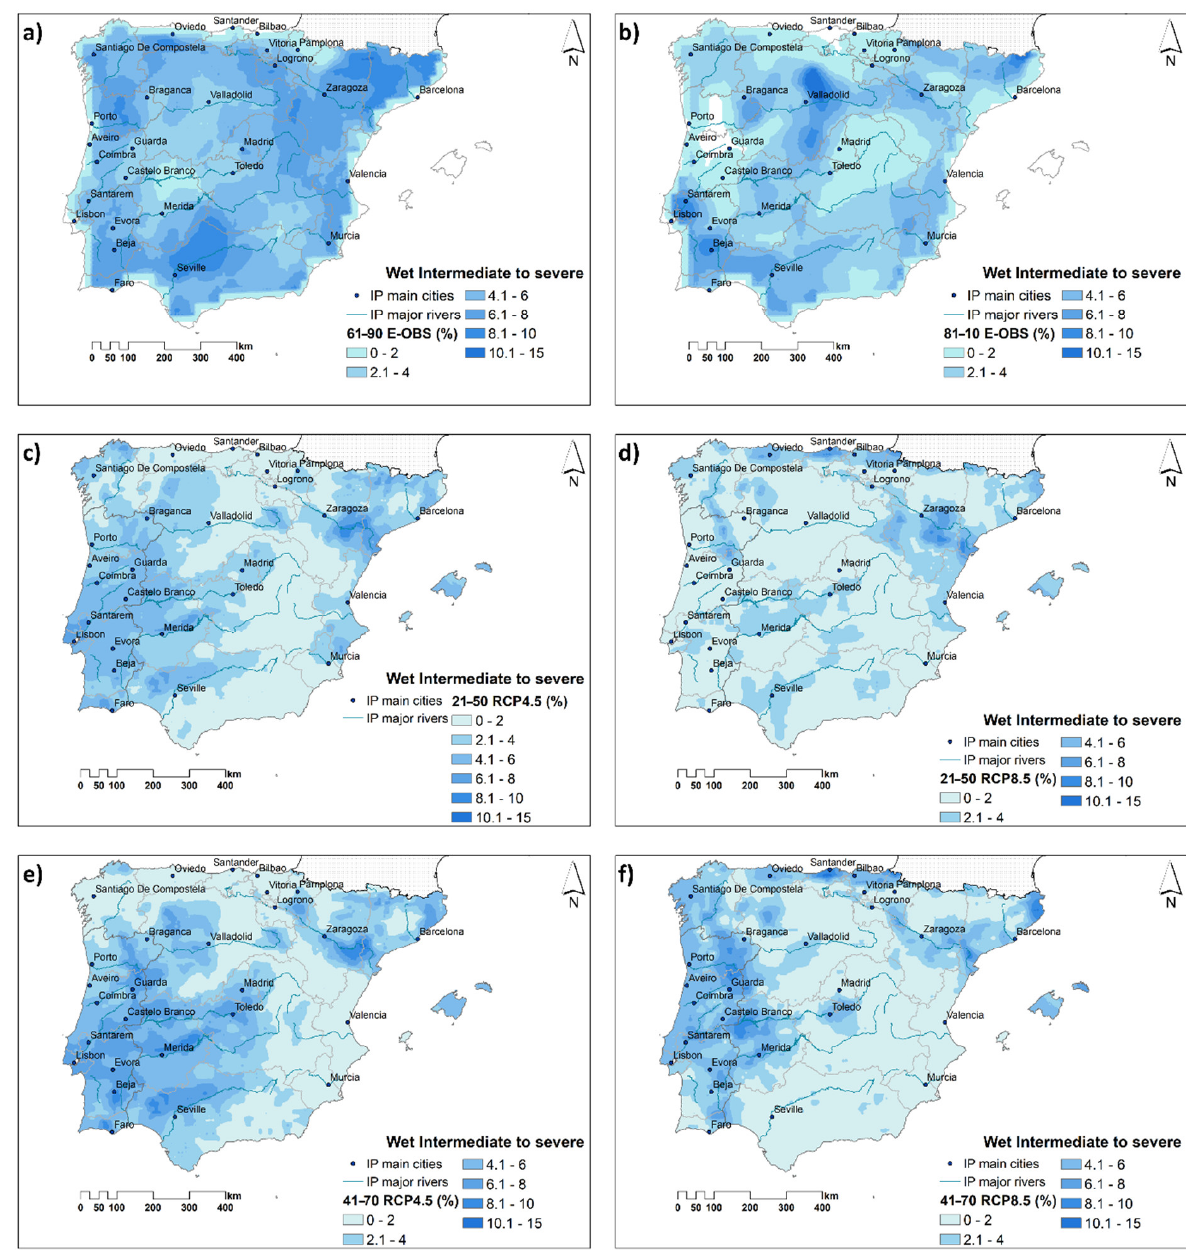
Figure 9. Probability (in %) of 12m-WASP intermediate-to-severe wet events in IP for the periods ( a ) 1961–1990, and ( b ) 1981–2010, ( c , d ) 2021–2050, ( e , f ) 2041–2070 under RCP4.5 (left) and RCP8.5 (right) (Note: NUTS 2 in grey contours).